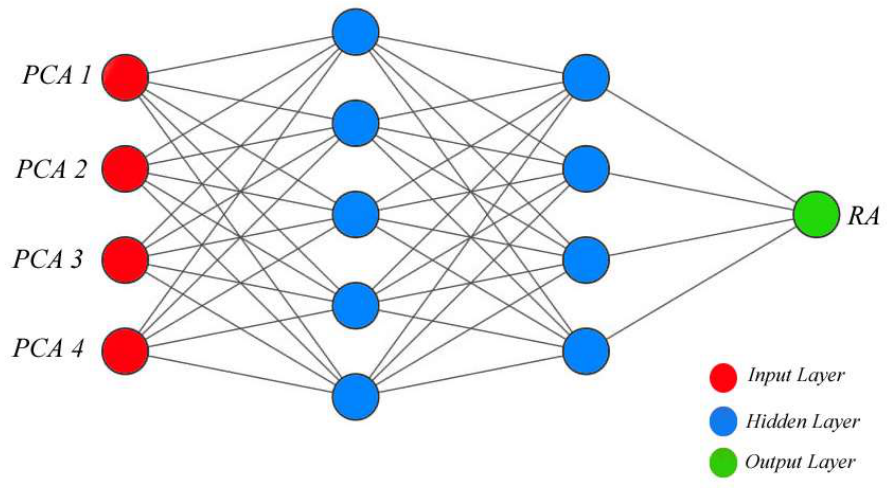
Figure 7. Topology of a feed-forward model with two hidden layers (4-5-4-1 topology). Based on Equation (2), the total No. of N H should be equal to or less than 9. There- fore, different architectures have a maximum of two hidden layers and a maximum of nine trained neurons. The employed architectures are given in Table 5 which include a total number of 20 models. In all models, the hyperbolic tangent stimulation function and the Levenberg–Marquardt training algorithm were used. In optimizing the ANN weights, the ABC algorithm as a strong optimization model was applied to optimize the ANN weights and ANN biases. ABC produces the least calculation error for the trained architecture. The properties of the ABC algorithm parameters are displayed in Table 6. Table 5. The trained ANN architectures.